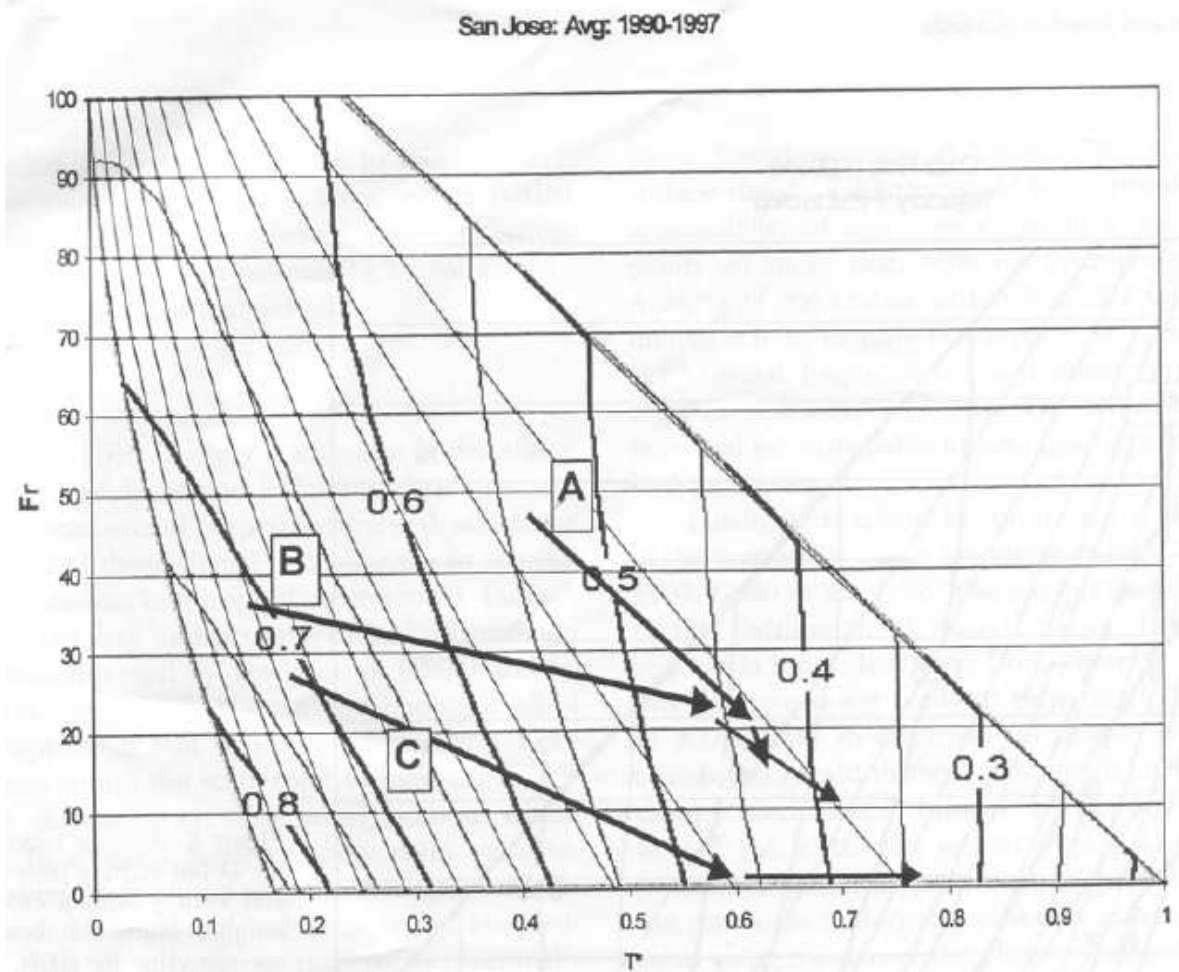
Figure 6. Average trajectories of clusters A, B and C (roughly determined from the scatter plot in Figure 5) for the period 1990 – 1995 and 1995-1997 (the two arrow segments for each